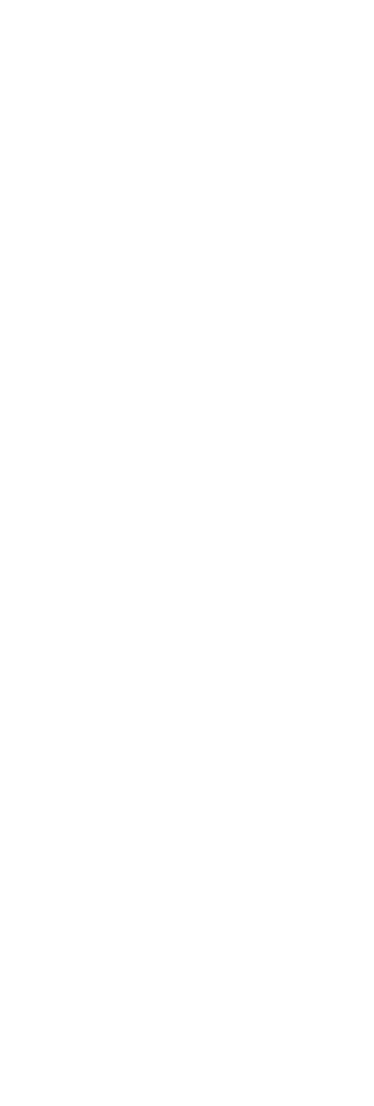
FIGURE 9 | Dietary MOS affected the gut microbial composition of juvenile M. amblycephala . Relative abundance of gut microbiota at phylum (A) , genus (B) , and species (C)